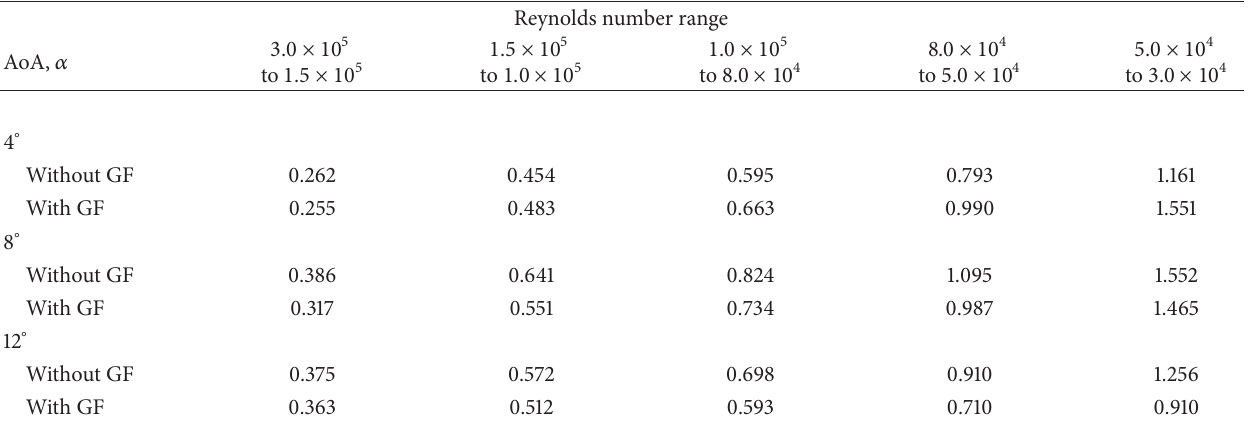
Table 5: Decrement in lift-to-drag ratio per every 10,000 decrease in Reynolds number for different ranges of Reynolds number. Reynolds number range